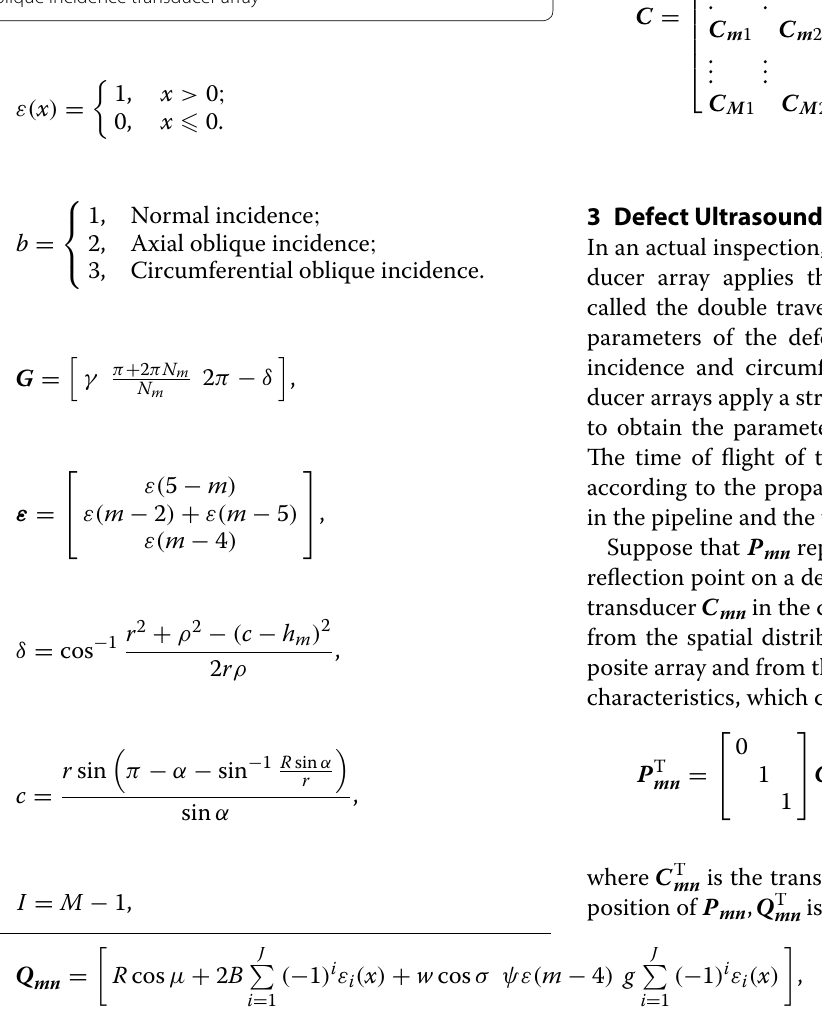
Figure 4 Two‑dimensional structural diagram of circumferential oblique incidence transducer